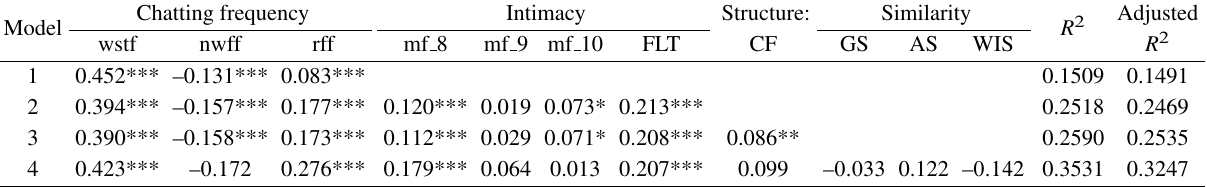
Table 2 Tie strength regressing on online interaction variables.